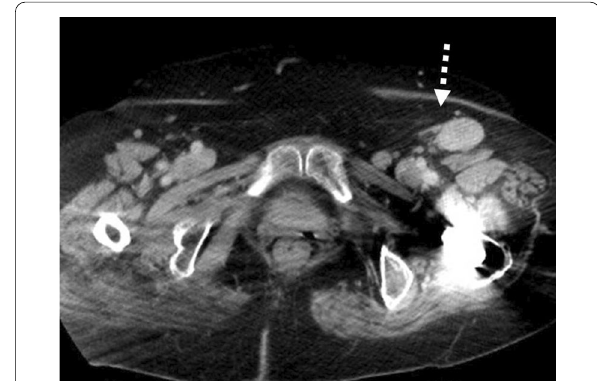
Fig. 1 The increasing size and numbers of left inguinal lymph nodes were clearly presented in enhanced pelvic CT. The finding was first detected 46 months after the breast cancer